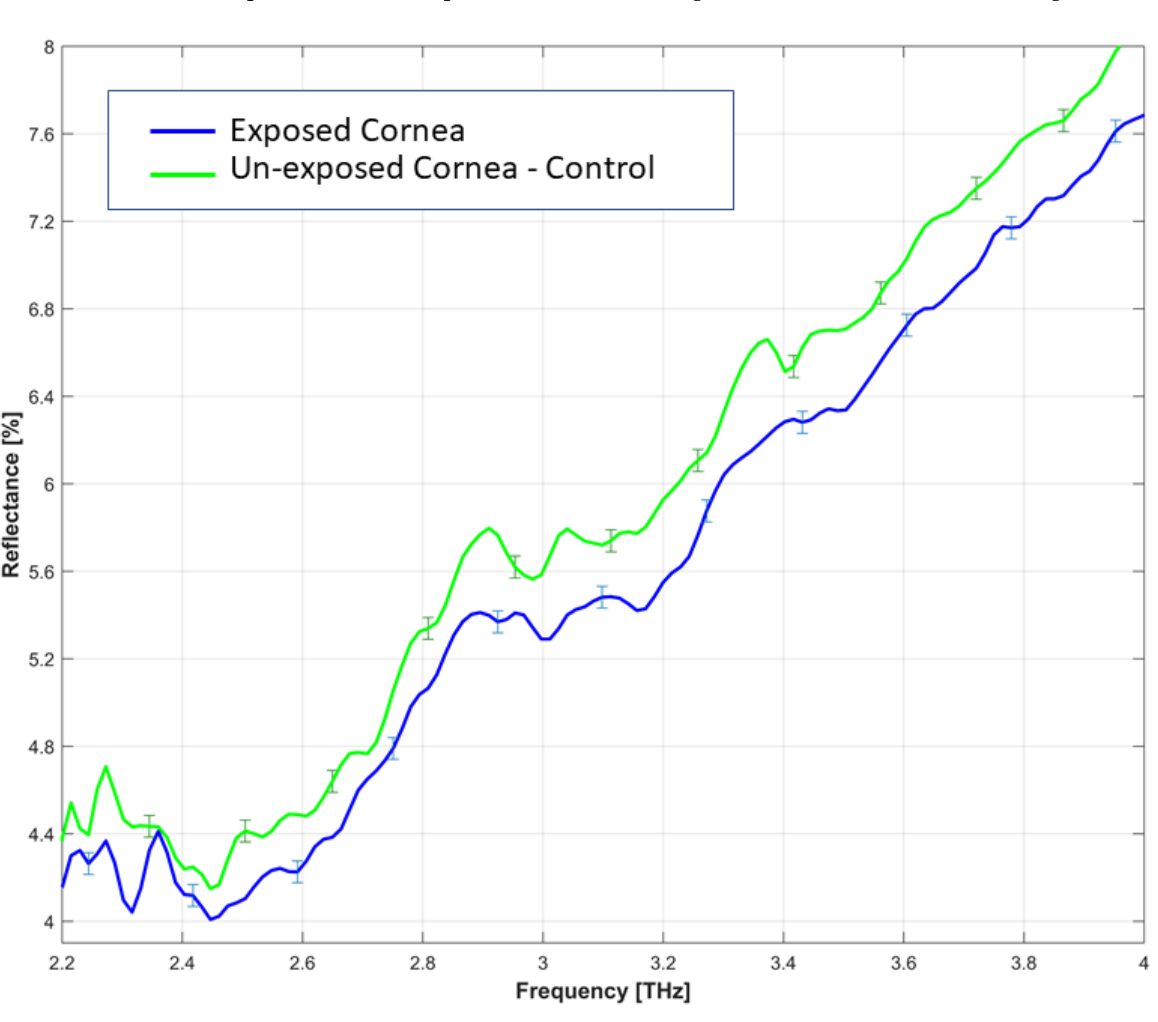
Figure 5. The reflectance spectrum of the exposed sample-test and the 4 hours unexposed cornea control was measured at partial reflection/partial transmission region below 5.0 THz. The data were normalised to air = 100% and represents a reduction in bound water of the exposed sample. The represented error bars of 0.05 are the standard deviation of measured reflectance data of exposed and unexposed samples, each obtained from 20